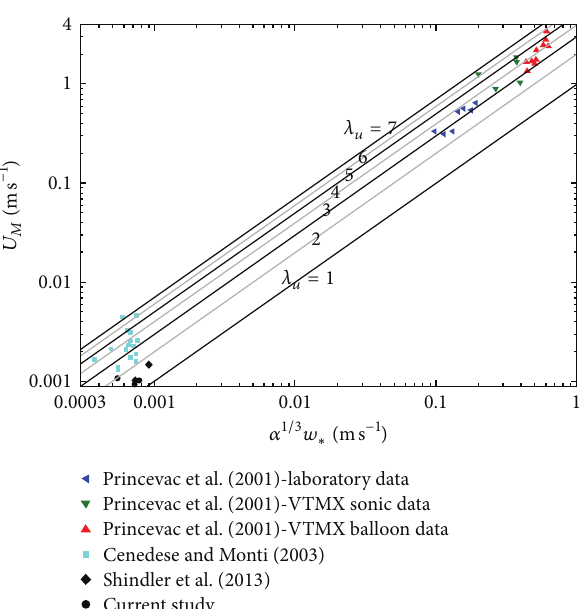
Figure 27: Comparison with Hunt et al. [7] theoretical